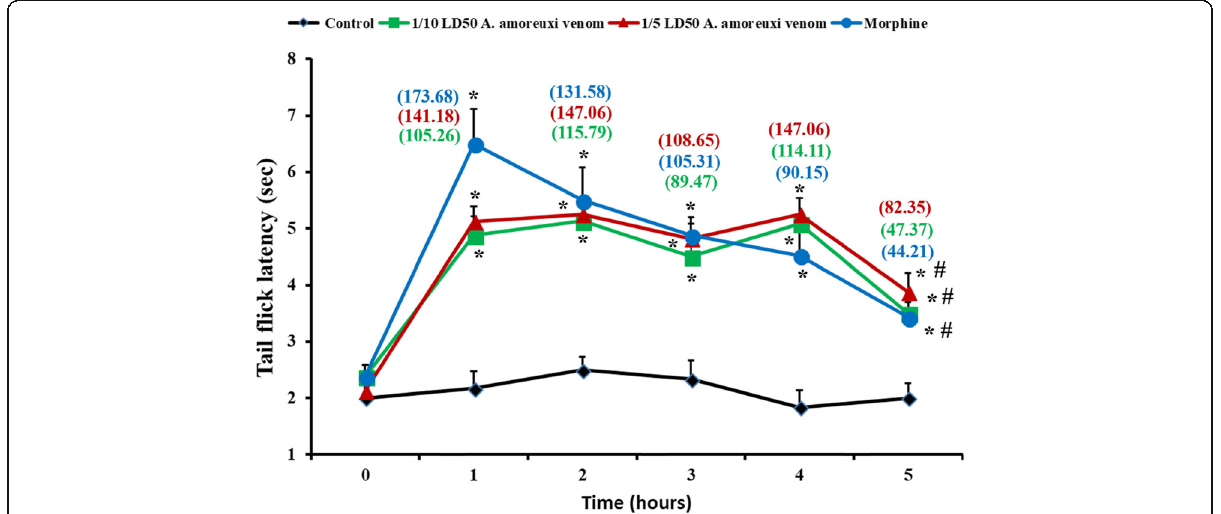
Fig. 2 Analgesic effect of A. amoreuxi venom using tail immersion test in rats. Effect of IP injection of 1/10 LD 50 (0.385 mg/kg) and 1/5 LD 50 (0.77 mg/kg) of venom on rat tail flick response. Data are presented as mean ± SEM (6 animals/group). (*) represents a significant difference between normal control and treated groups using Students unpaired t test ( p < 0.05). (#) represents a significant difference between all groups at time intervals in each treatment using one-way ANOVA ( p ≤ 0.05). Values between brackets represent